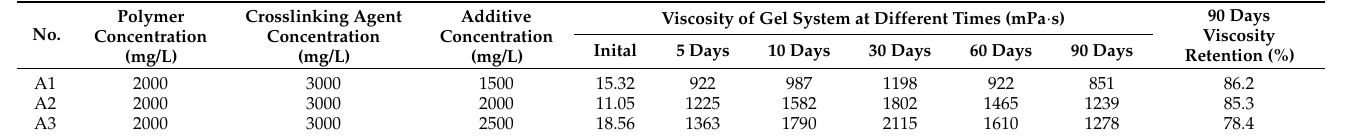
Table 1. Viscosity changes recorded for the hydrophobic weak gel system under conditions of varying agent concentrations.